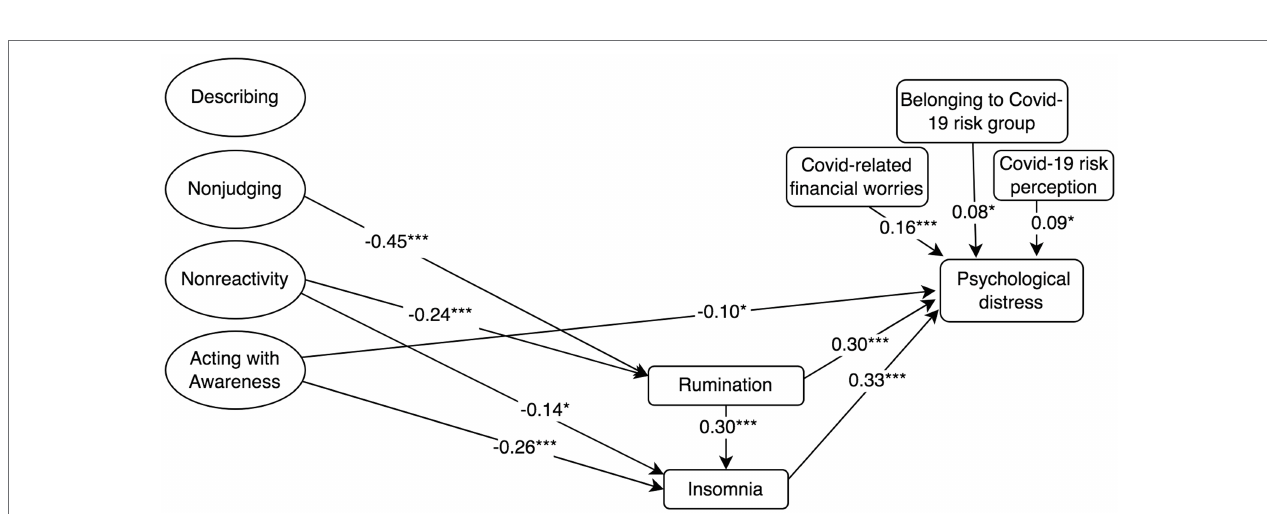
FIGURE 6 | Standardised mediation Model 6 of the effect of the five facets of mindfulness on COVID-19-related psychological distress. Psychological impact of COVID-19 = IES-R, 22-item Impact of Event Scale-Revised; Rumination = RSS-SF, 10-item Rumination Response Scale-Short Form; Cognitive Reappraisal and Suppression = ERQ, 10-item Emotion Regulation Questionnaire; Insomnia = ISI, 7-item Insomnia Severity Index; and Mindfulness and facets = FFMQ-SF, 24-item Five-Facets Mindfulness Questionnaire-Short Form. † p < 0.10; * p < 0.05; ** p < 0.01; and *** p ≤